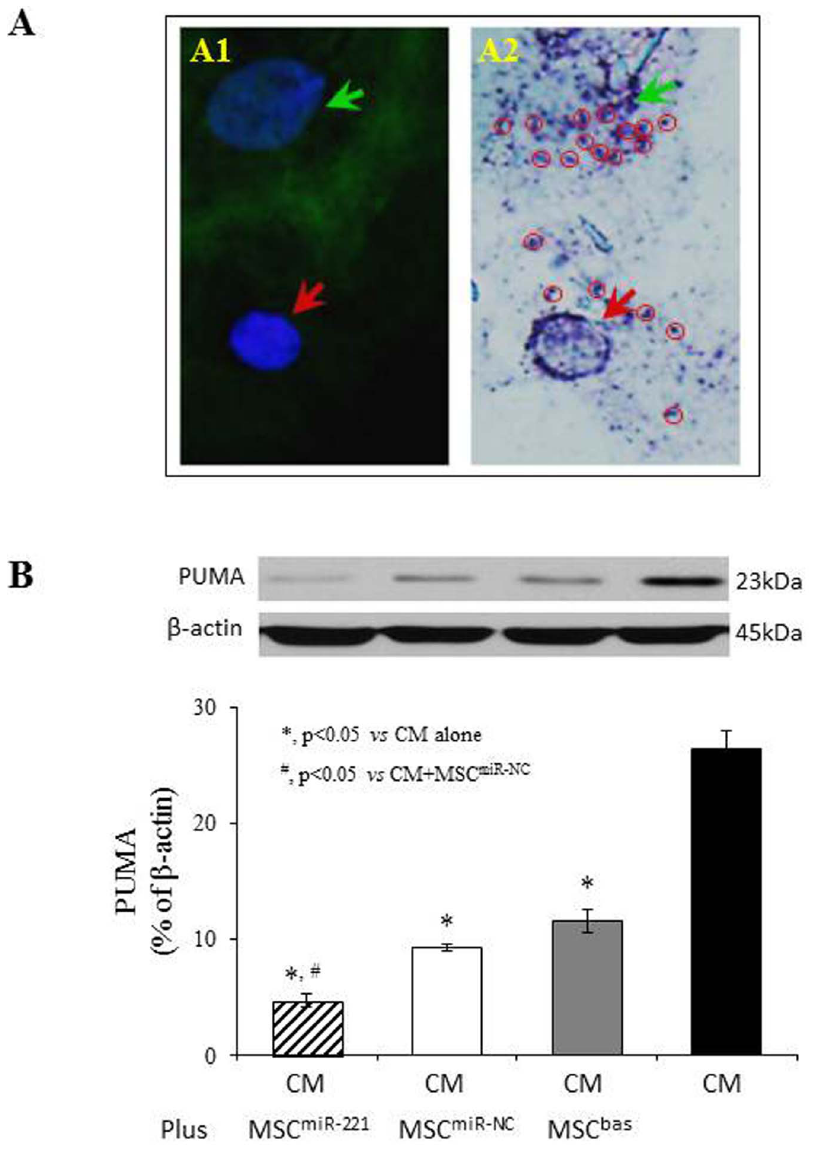
Figure 6. miR-221 transferred from MSC to CM and reduced PUMA expression in CM. Panel A: In situ hybridization staining of miR-221 in CM co-cultured with MSC miR-221 for 48 hours. miR-221 is shown as a purple-blue signal (red circles) which was observed in both GFP positive MSC (green arrow) and GFP negative CM (red arrow). Panel B: Western blot of PUMA and corresponding semi-quantitative data in CM co-cultured with various MSC in a dual-chamber